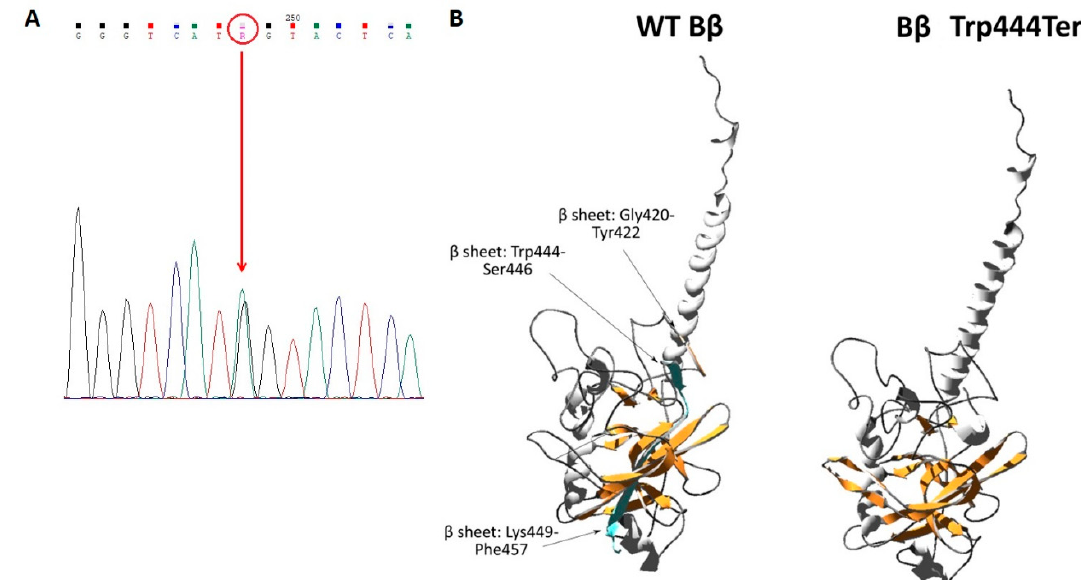
Figure 4. ( A ): Electropherogram of the heterozygous mutation in exon 8 of the FGB gene (c.1421G > A), ( B ): Analysis of the B β Trp444Ter mutant model. Differences between the secondary structure of the WT B β chain and the B β Trp444Ter are indicated. The amino acids missing in the mutant chain are displayed in blue. Alpha helices and beta sheets are colored in grey and orange, respectively, while the remaining residues are assigned as dark grey. Amino acids are numbered according to the mature protein sequence. Images were prepared using Swiss-PdbViewer 4.1.0, POV-Ray, and PDB file 1FZA [9].